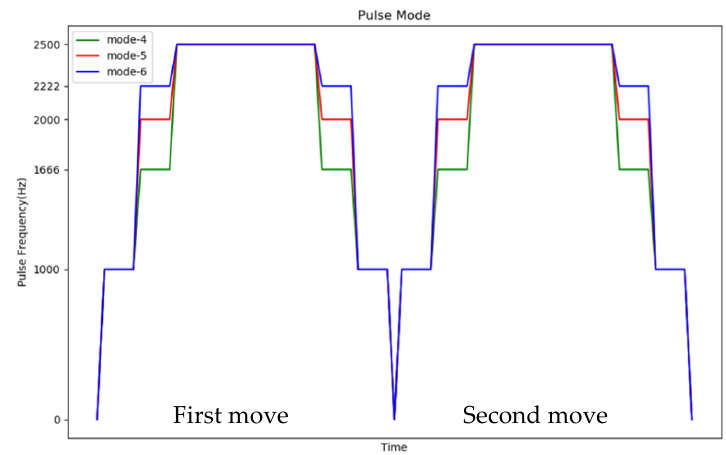
Figure 25. Time distribution diagram 1 of pulse frequency in the second control mechanism.